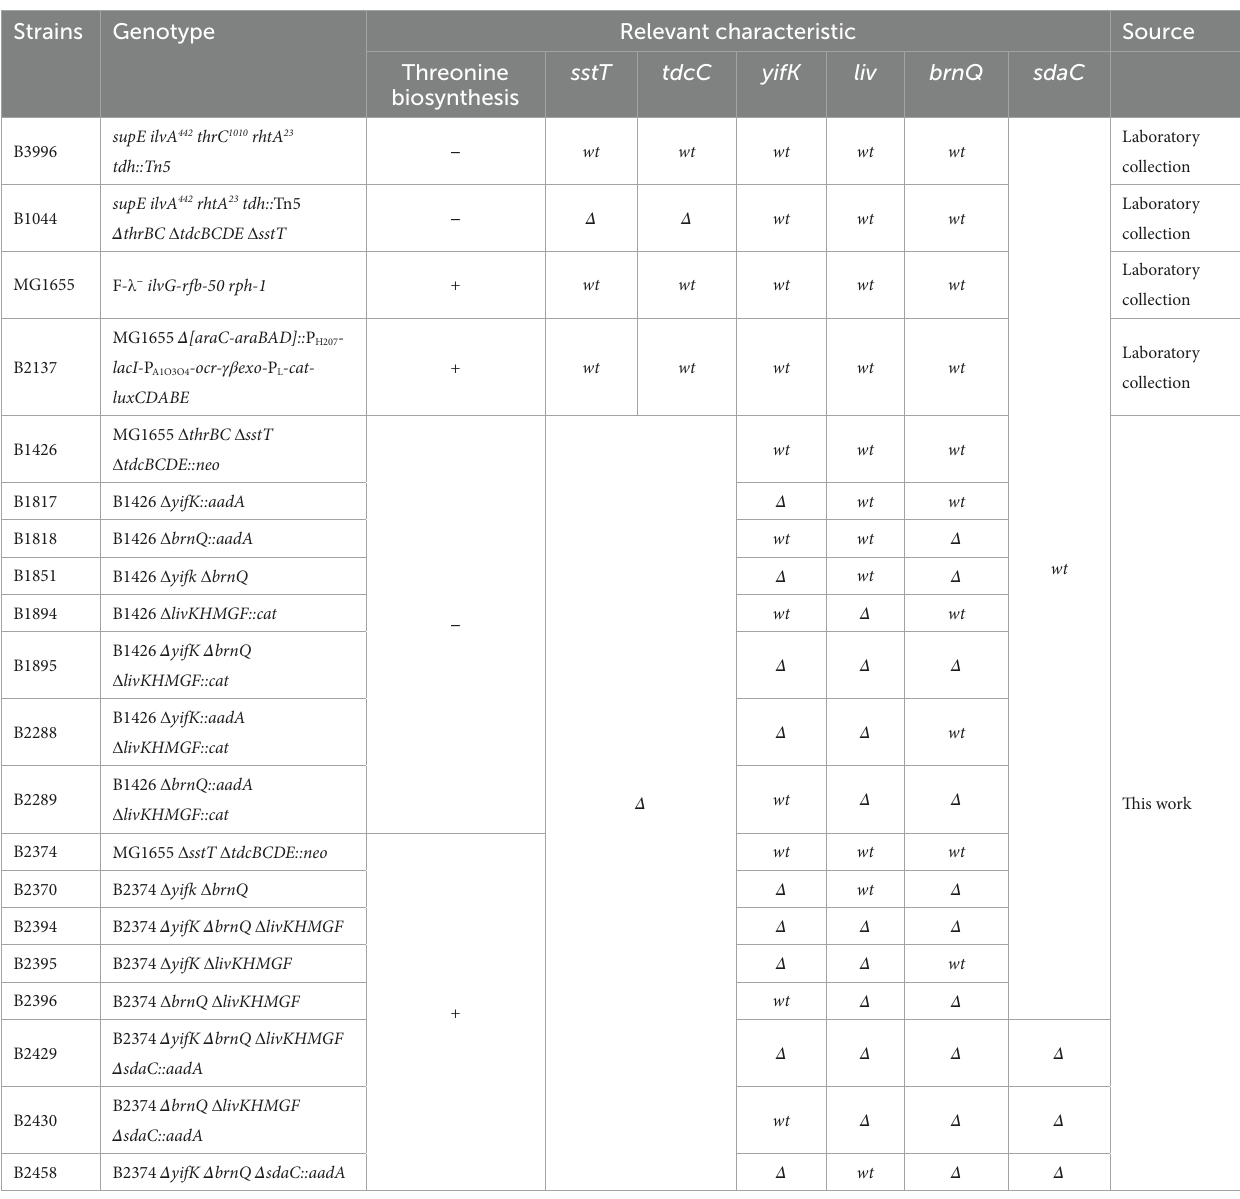
TABLE 1 Bacterial strains used in this work. Strains Genotype Relevant characteristic